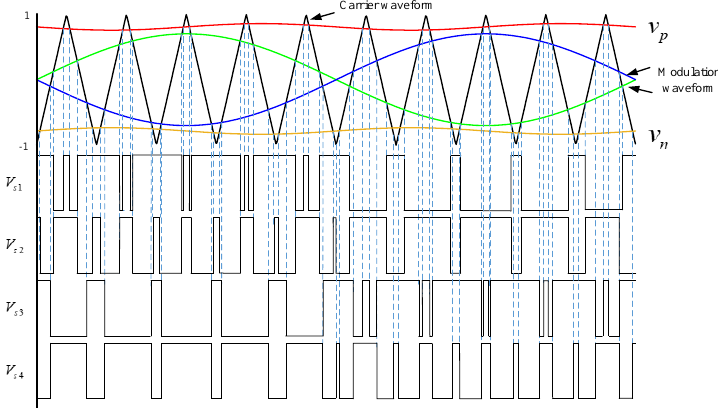
Figure 3. Proposed ripple vector cancellation modulation strategy (RVCMS) .